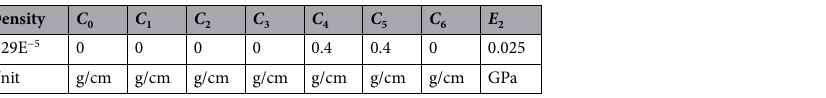
Table 2. Air material